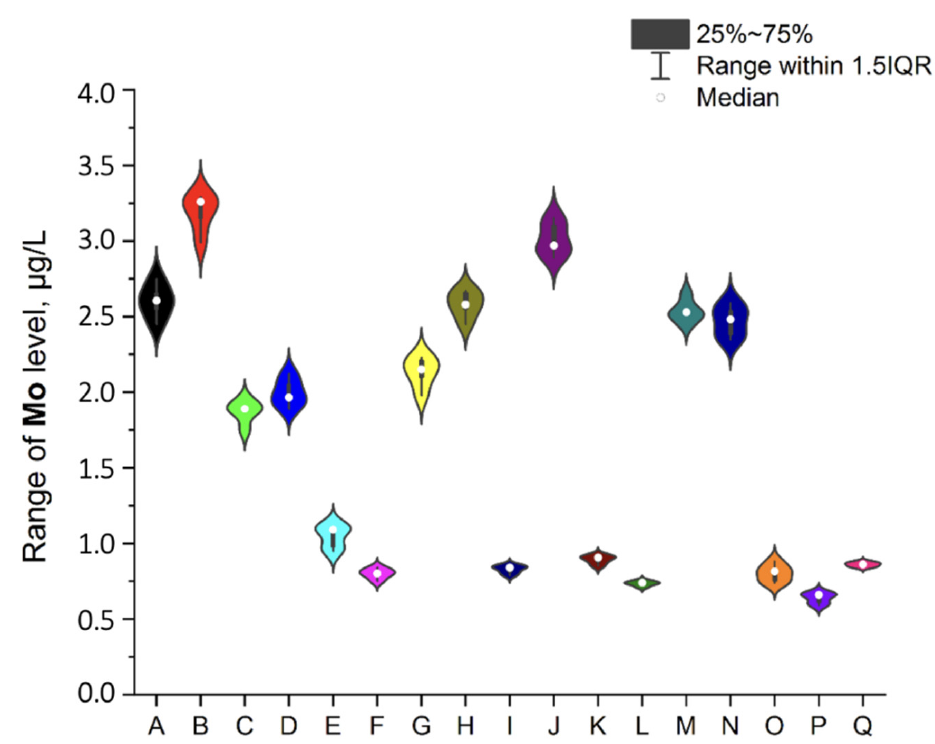
Figure 5. The plot as a violin with the box for the Mo level ( µ g/L) in the examined products (A–Q).